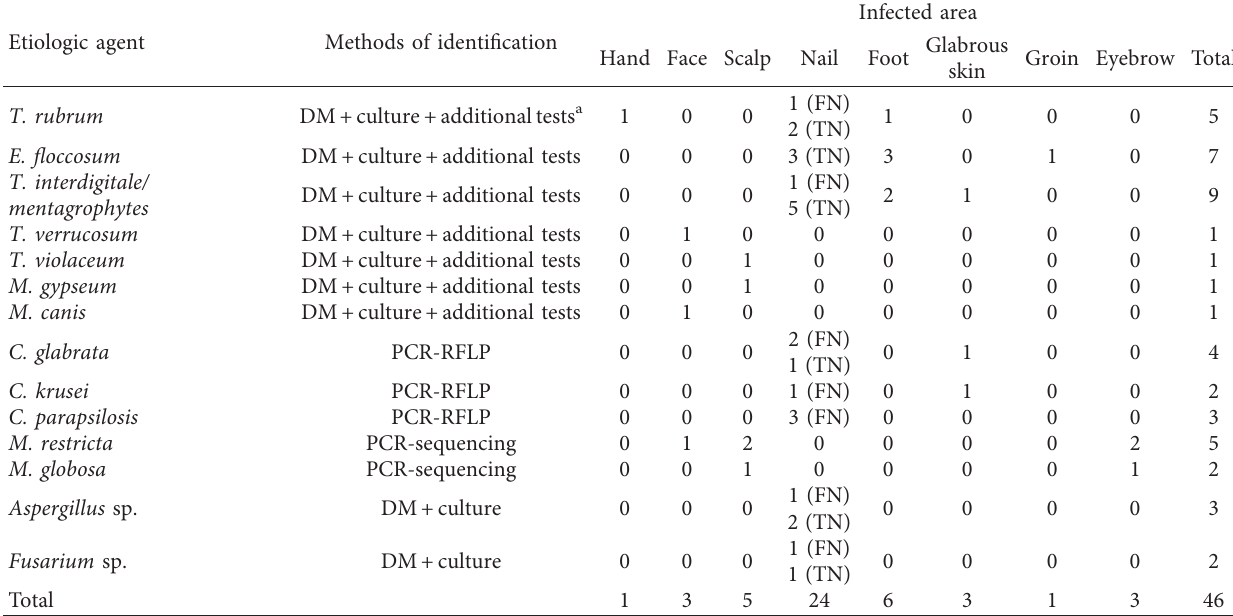
Table 3: Etiologic agents of fungal infections isolated from psoriatic patients.